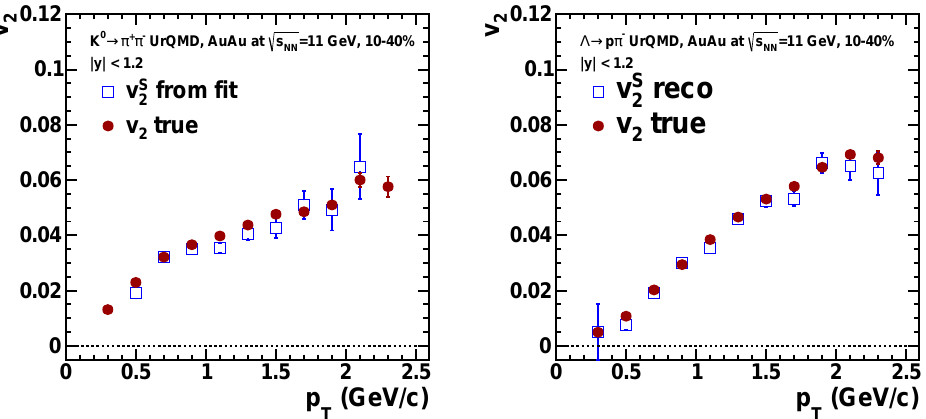
Figure 12. p T dependence of v 2 { Ψ 1,FHCal } of K 0 ( left ) and Λ ( right ) particles for 10–40% central S √ s NN = 11 GeV: open symbols represent the “true” v 2 results and filled Au + Au collisions at symbols the “reco” v 2